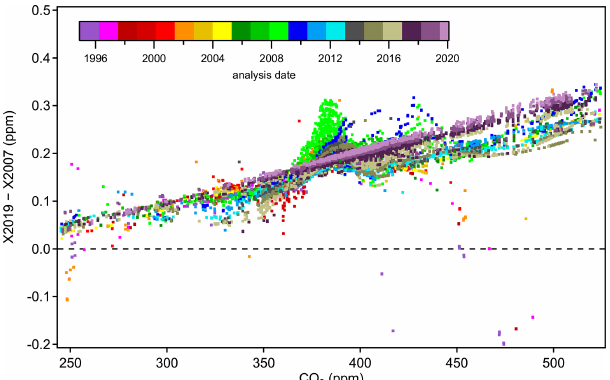
Figure 11. Differences between X2019 and X2007 assignments to tertiary standards from 1995 to 2020. Each data point represents one analysis record (over 25000 records shown), and a full calibration of a tertiary standard involves multiple analysis